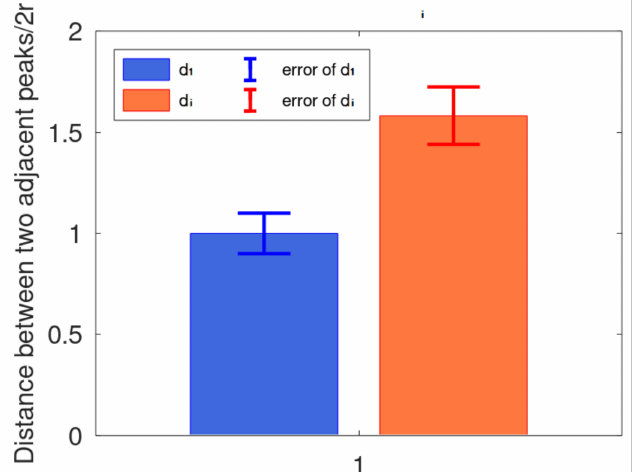
Figure 12. Distance between two adjacent peaks. The mean distance between the two adjacent peaks is 2 × r as d 1